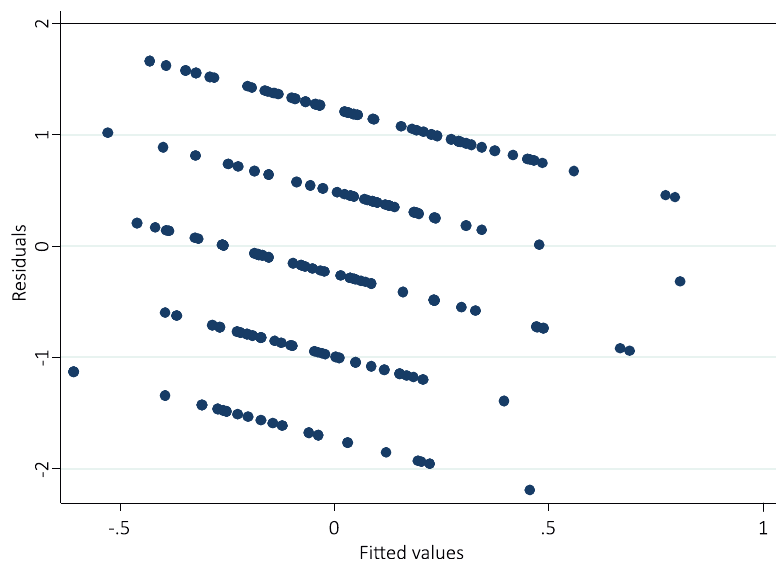
Figure 1. Residual variance graph of FMB